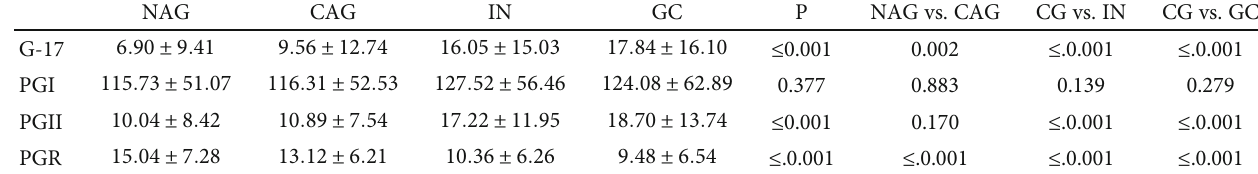
Table 2: Laboratory examination results of di ff erent disease states.